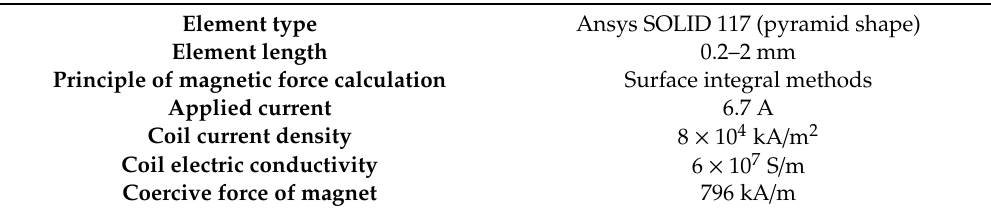
Table 3. Parameters of the FEM